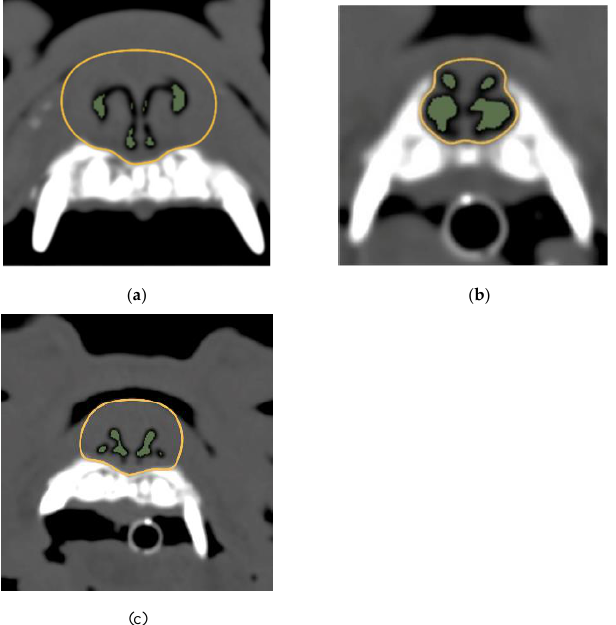
Figure 3. Images of canine teeth levels and the AA/NC ratios for three dog breeds. ( a ) French bulldog; ( b ) shih tzu; ( c ) pug. The following are typical images and measurements. The AA/NC ratio was the highest in Shih Tzus (27.98%). There were no clear differences between the French bulldogs (5.07%) and pugs (7.05%). AA/NC, airway cross-sectional area/total nasal cavity area.